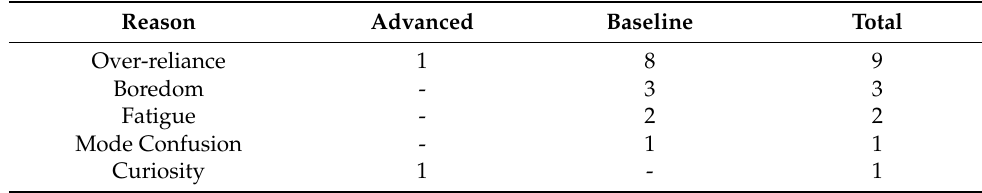
Table 3. Reasons for drivers’ engagement in the given visual-manual NDRAs when driving with L2 automation engaged divided by HMI condition.